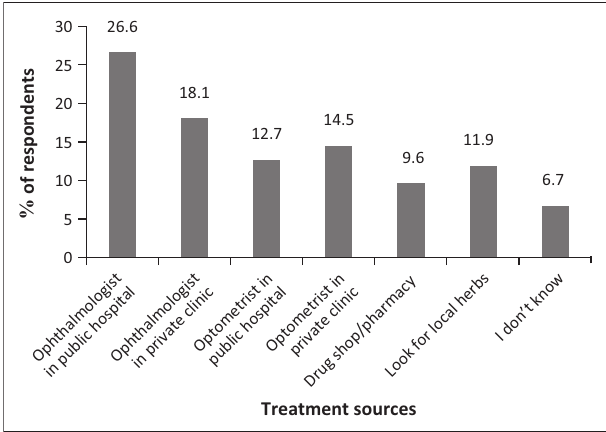
FIGURE 7: Sources of treatment by